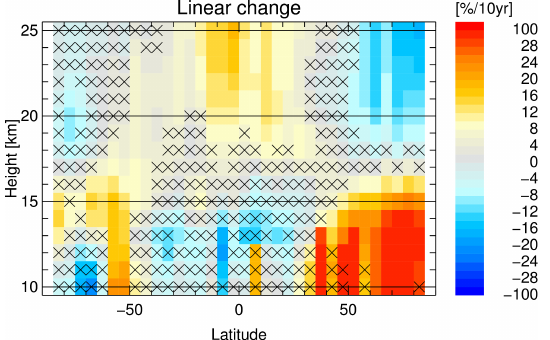
Figure 10. Linear change from the multivariate linear regression for SCIAMACHY zonal mean data on a 5 ◦ latitude and 1km height grid. Non-significant values ( < 2 σ ) are marked with